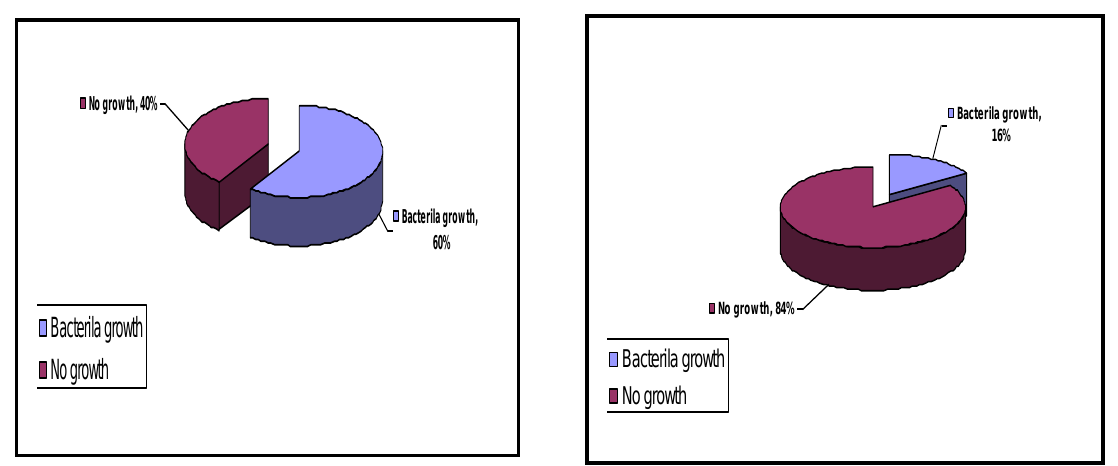
Figure 3. Bacterial colonization rates